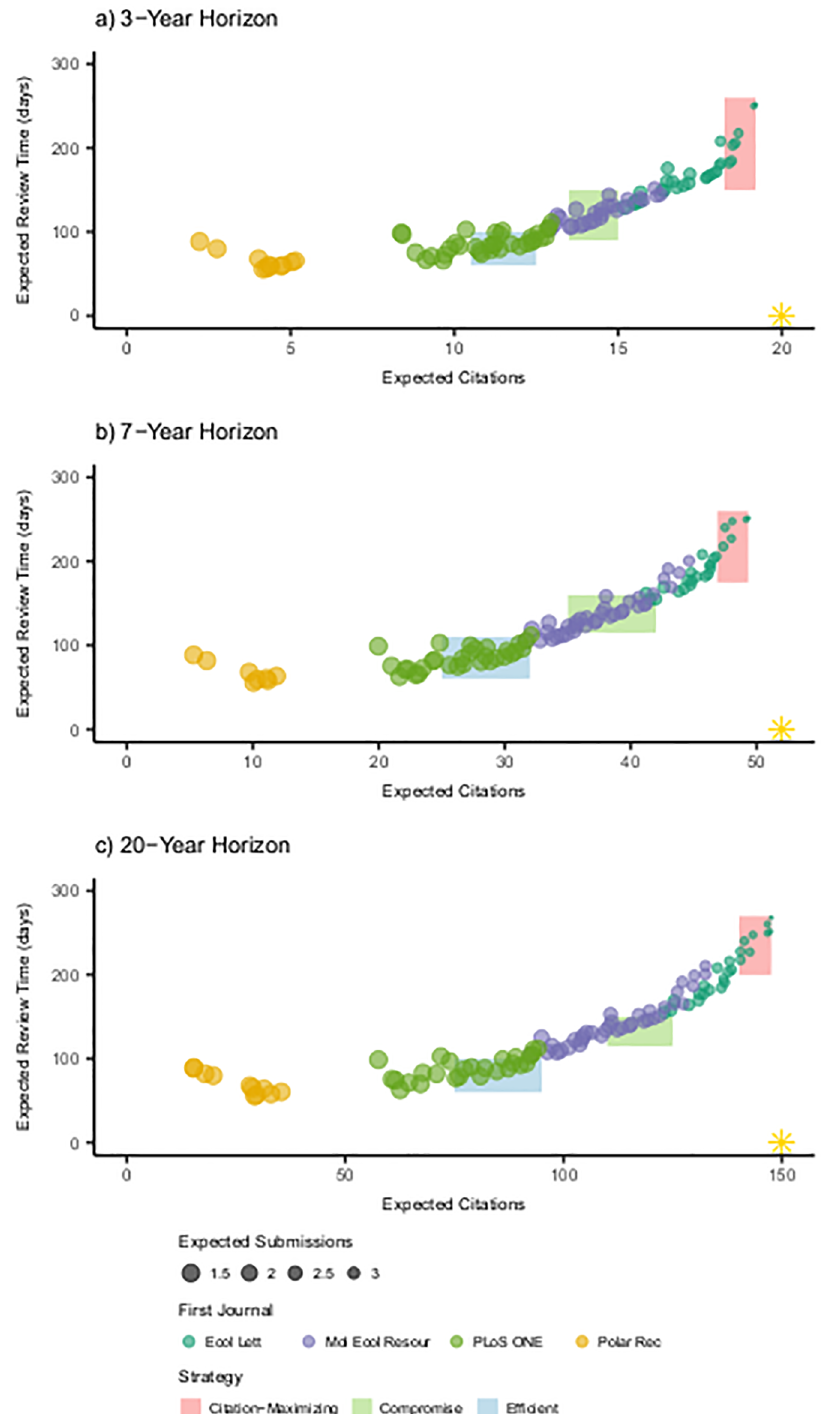
Fig 3. Pareto-approximate solutions. Approximate Pareto fronts for the (a) junior researcher ( T = 3 years), (b) tenure-seeking researcher( T = 7 years) and (c) tenured researcher ( T = 20 years). The shadedboxes depict the three strategies: Efficient (blue shaded box), Compromise(green shadedbox) and Citation- Maximizing (red shaded box). The gold stars in the lower-rightcorner represent the target directionfor the represented